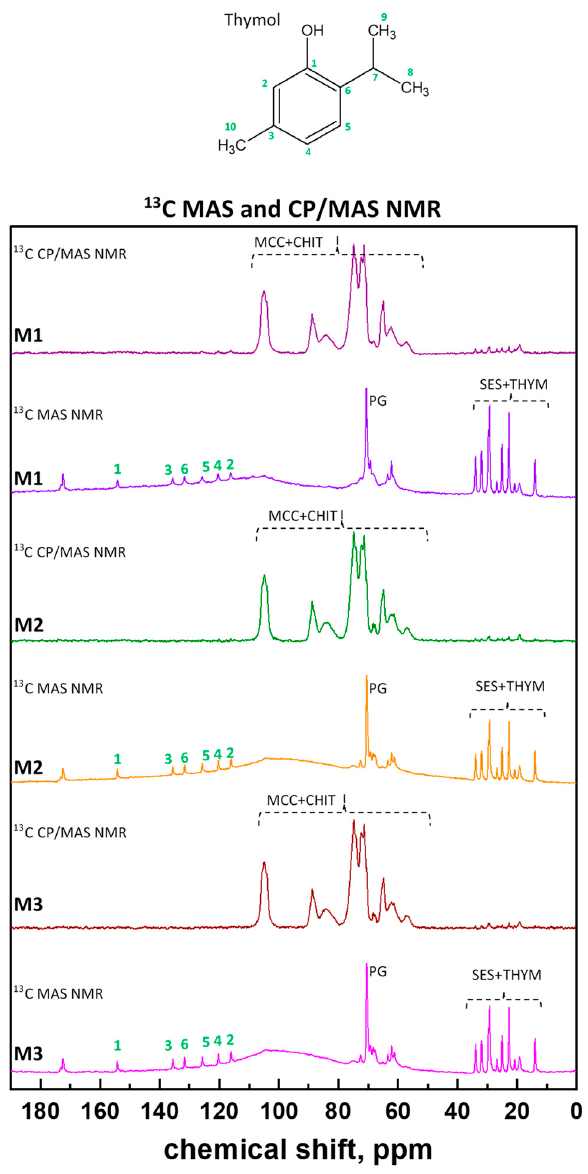
Figure 5. Molecular structure of thymol with atom numbering used in NMR spectra and the 13 C CP/MAS and 13 C MAS NMR spectra of the prepared pellet cores (M1, M2, and M3).